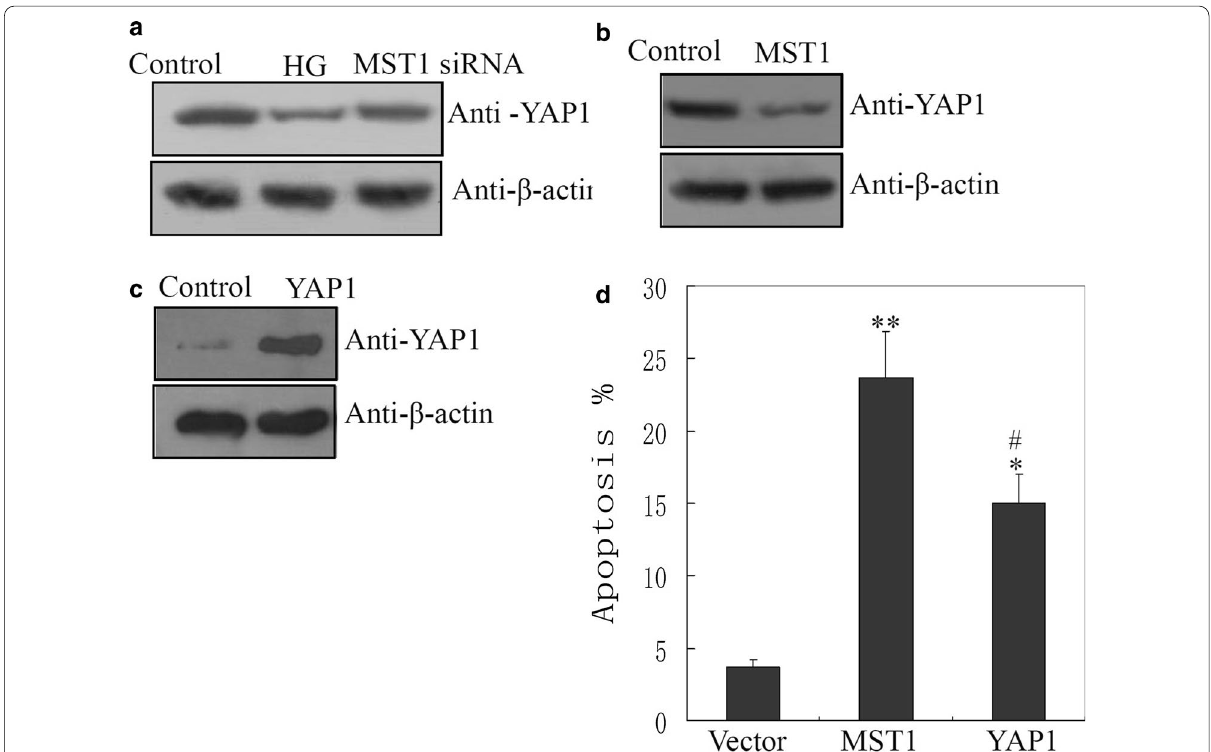
Fig. 4 Down-expression of YAP1 are associated with MST1-mediated cardiomyocyte apoptosis. a The decrease YAP1 protein level in response to HG was remarkably suppressed when H9C2 cells were transfected with MST1 siRNA for western blotting. b Western blotting estimated of the protein level of YAP1 after transfection with MST1 expression plasmid. c Western blotting confirmation of the ectopic expression of YAP1 in H9C2 cells after transfection with YAP1 expression plasmid. d Over-expression of YAP1 suppressed the increase apoptotic rate in H9C2 cells, which was mediated by MST1 induced by